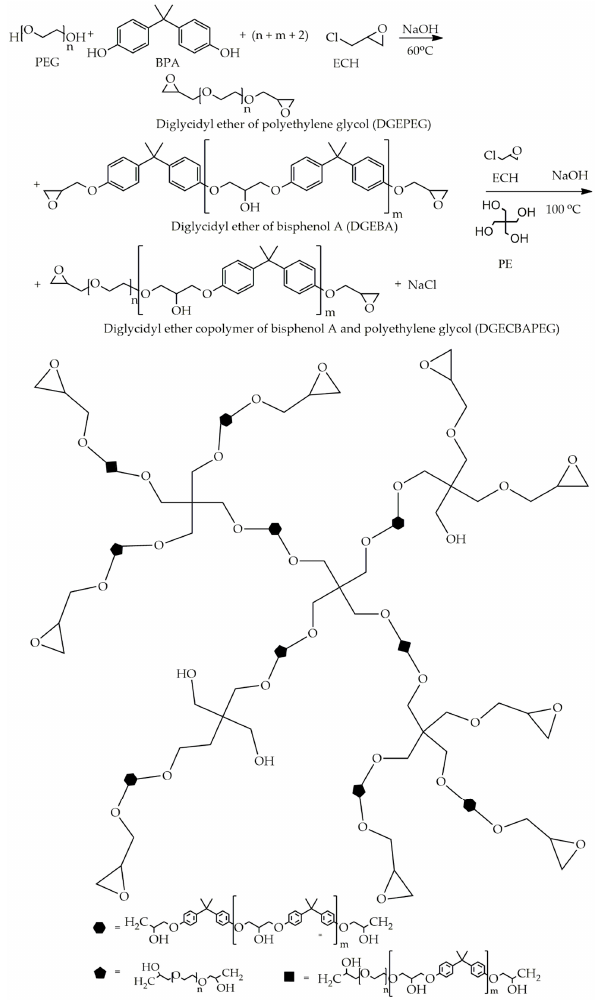
Figure 2. The synthesis and possible structure of bisphenol A/polyethylene glycol (BPA/PEG) hyperbranched epoxy resin [21] .